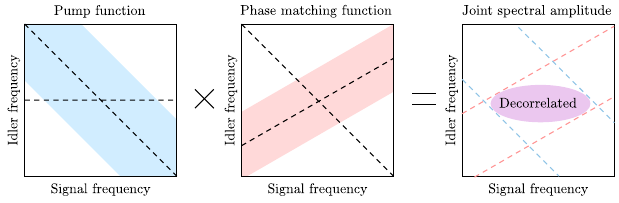
FIG. 10. The product of a pump function (energy conservation) and a phase-matching function (momentum conservation) can yield a separable joint